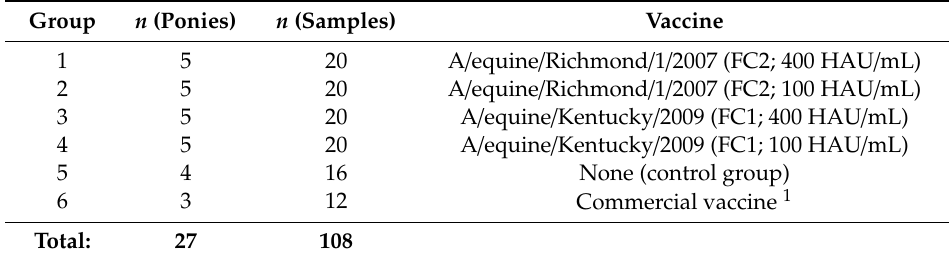
Table 1. Details of serum set #1. HAU / mL = haemagglutinin (HA) unit per